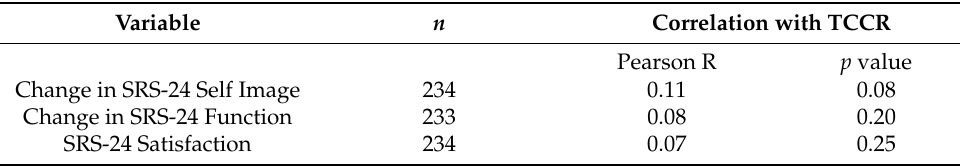
Table 2. Correlations with Clinical Outcome